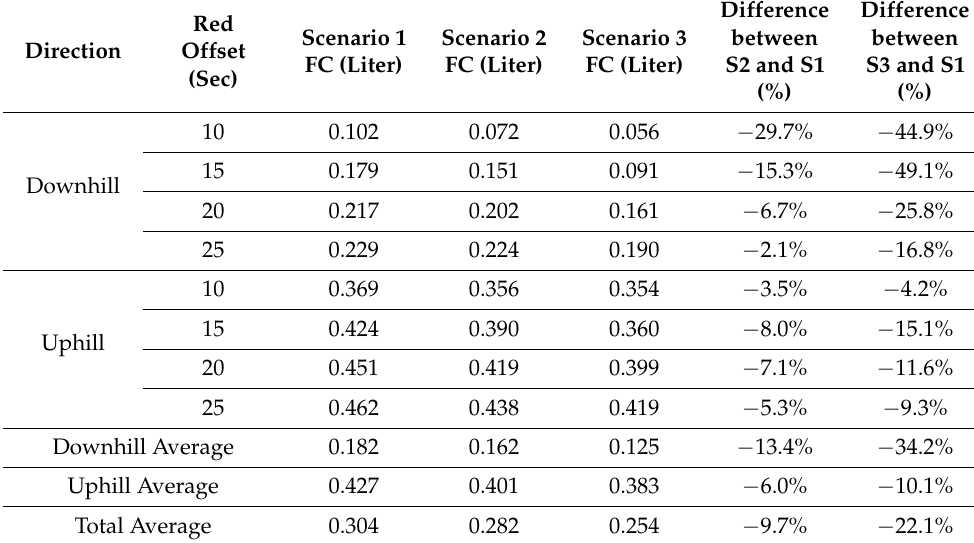
Table 2. Average trip fuel consumption (FC)